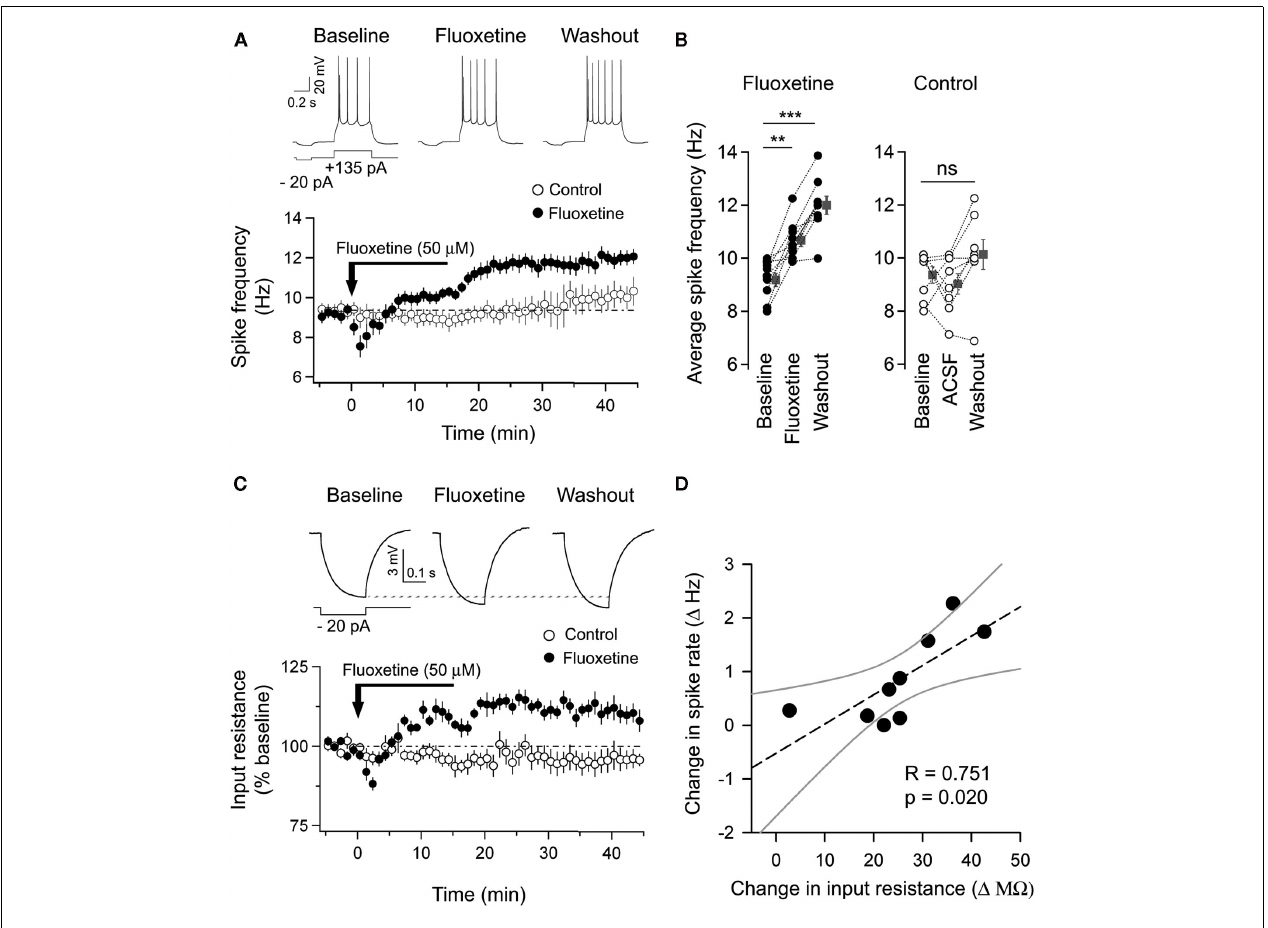
control neurons. (C) Top , the voltage response to hyperpolarizing current injections used to measure the input resistance is shown for a representative neuron before, during, and after fluoxetine application. Bottom , time-course of input resistance averaged (per minute) and normalized (%) to the baseline for fluoxetine and aCSF-treated control neurons. (D) Correlation plot indicating that the rise in spike frequency in the majority of fluoxetine-treated neurons was significantly correlated with a corresponding increase in input resistance.The dotted and gray lines indicate the linear-fit and 95% confidence bands respectively. Error bars represent SEM; ** p < 0.01, *** p <